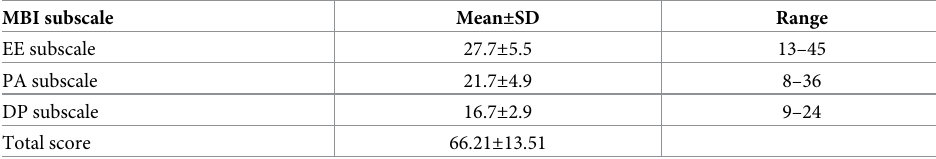
Table 2. MBI subscale scores among the participants (n = 168).